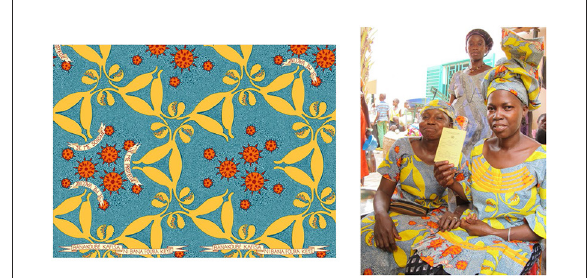
FIGURE1 Story-telling cloth for cervical cancer prevention. The photo on the left shows the story-telling cloth pattern. It illustrates the HPV virus, cervix, uterus, and fallopian tubes. Healthy cells surround each cervix and transform into cancerous cells as they encounter the HPV virus. The blue background depicts healthy cells surrounding each cervix that transform into cancerous cells as they encounter the HPV virus. The photo on the right shows two women wearing an outfit made with the fabric showing their CC screening card, obtained after a first CC screening as a reminder to come back yearly (Permission given for